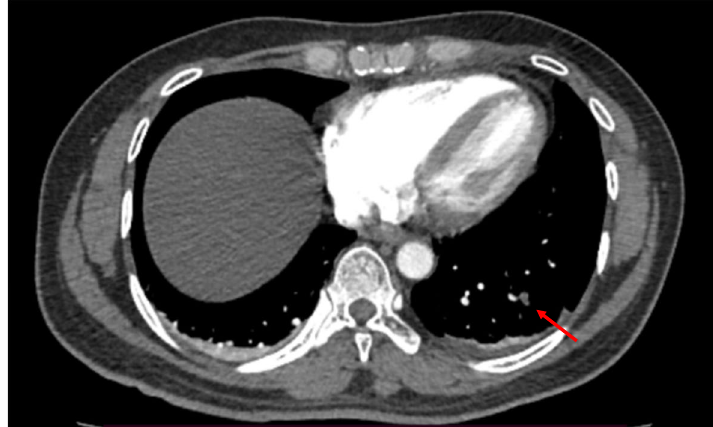
Fig. 1 A CT pulmonary angiogram revealed a pulmonary embolism in the left posterior segment pulmonary